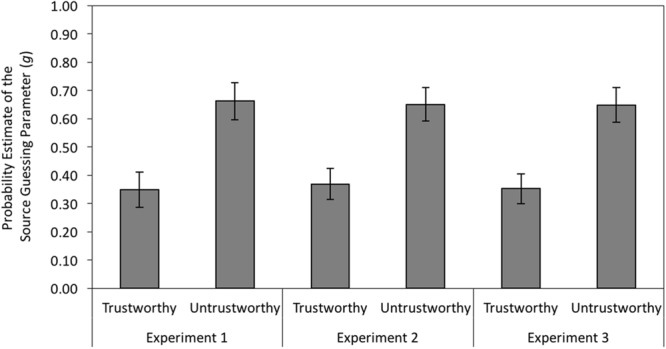
Estimates of the guessing parameter g representing the probability to guess that a person was a cheater rather than a cooperator as a function of facial trustworthiness (trustworthy vs. untrustworthy) in Experiment 1 (without cognitive load) and in Experiments 2 and 3 (with cognitive load). The error bars represent the 95% confidence intervals.